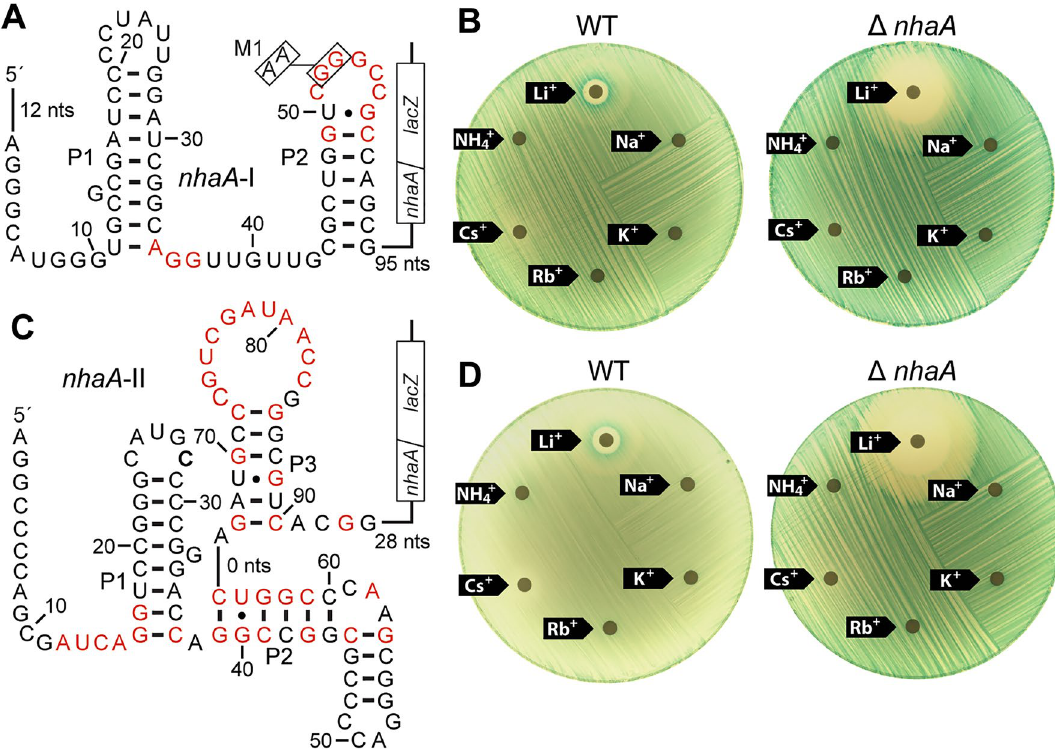
Figure 2. Li + triggers gene expression mediated by bacterial nhaA -I and nhaA -II motif RNAs. ( A ) A nhaA -I riboswitch-reporter fusion construct was created by fusing a representative associated with the nhaA gene of Azorhizobium caulinodans to a β-galactosidase gene ( lacZ ). Red nucleotides correspond to the highly conserved nucleotides characteristic of this RNA motif class (Fig. 1A). Boxed nucleotides identify locations of G-to-A mutations present in construct M1, which is a mutant riboswitch RNA used in several subsequent experiments. ( B ) Agar-diffusion assays were conducted with E. coli cells (either wild type [WT] or a nhaA gene deletion [Δ nhaA ] strain) carrying the nhaA -I reporter construct in A. Cells were spread on LBK (pH 9.1) agar media containing X-gal, and filter disks using 10 μL applications of 5 M chloride salts of various monovalent ions as indicated, except that reduced concentrations of KCl (3 M) and RbCl (0.5 M) were used due to limited solubility. ( C ) A nhaA -II riboswitch-reporter fusion construct was created by fusing a representative associated with the nhaA gene of Brevundimonas subvibrioides to lacZ . Additional annotations are as described for A. ( D ) Agar- diffusion assays with various cations were conducted with the nhaA -II reporter as described in C. Additional annotations and details are as described for